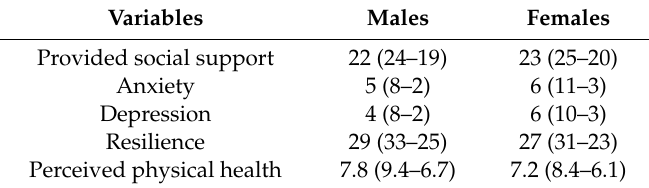
Table 2. Descriptives (Md (IQR)) of the variables with significant di ff erences by gender.